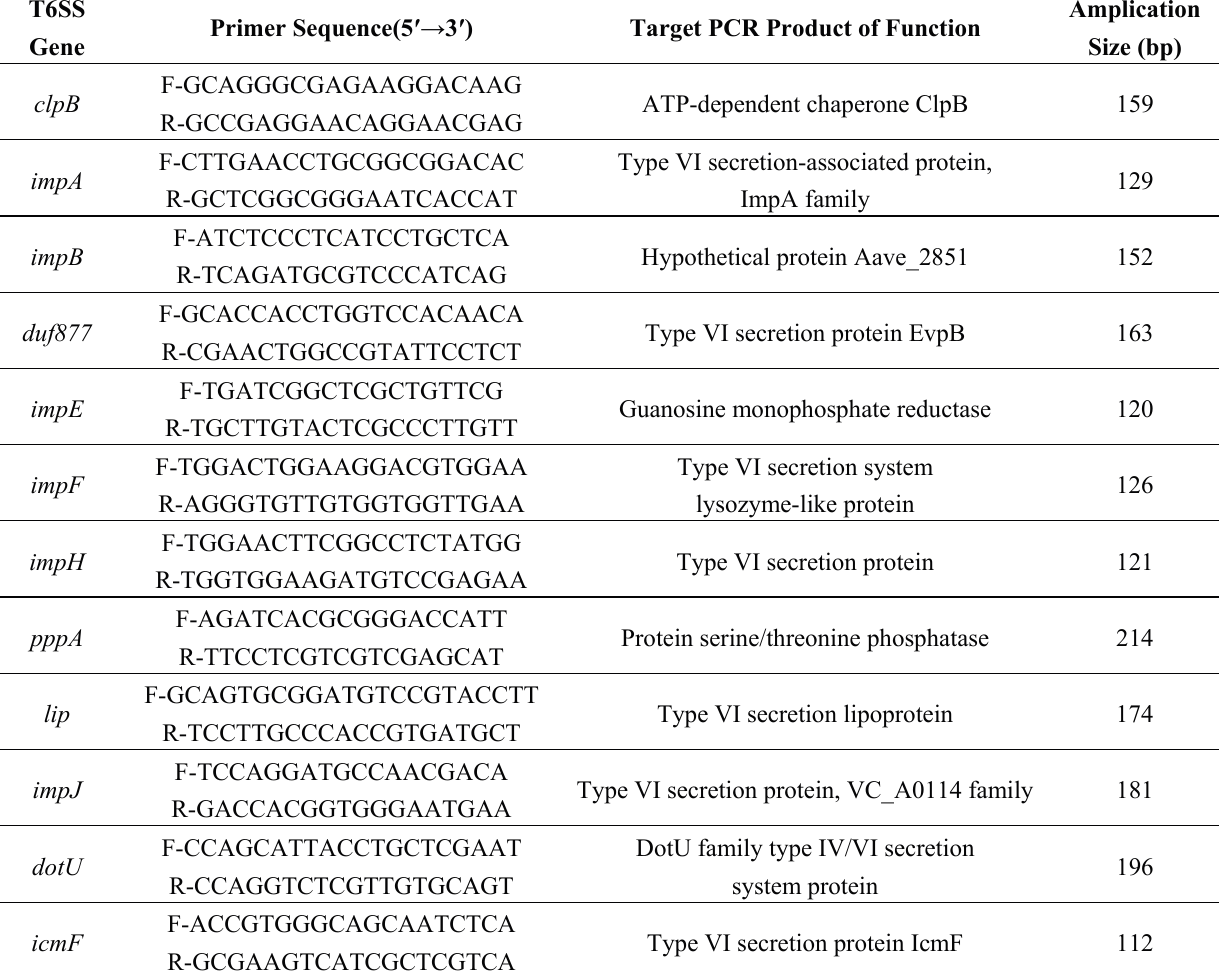
Table 3. Primers of T6SS genes used for quantitative real-time PCR (qPCR) of Acidovorax avenae subsp. avenae RS-1 in this